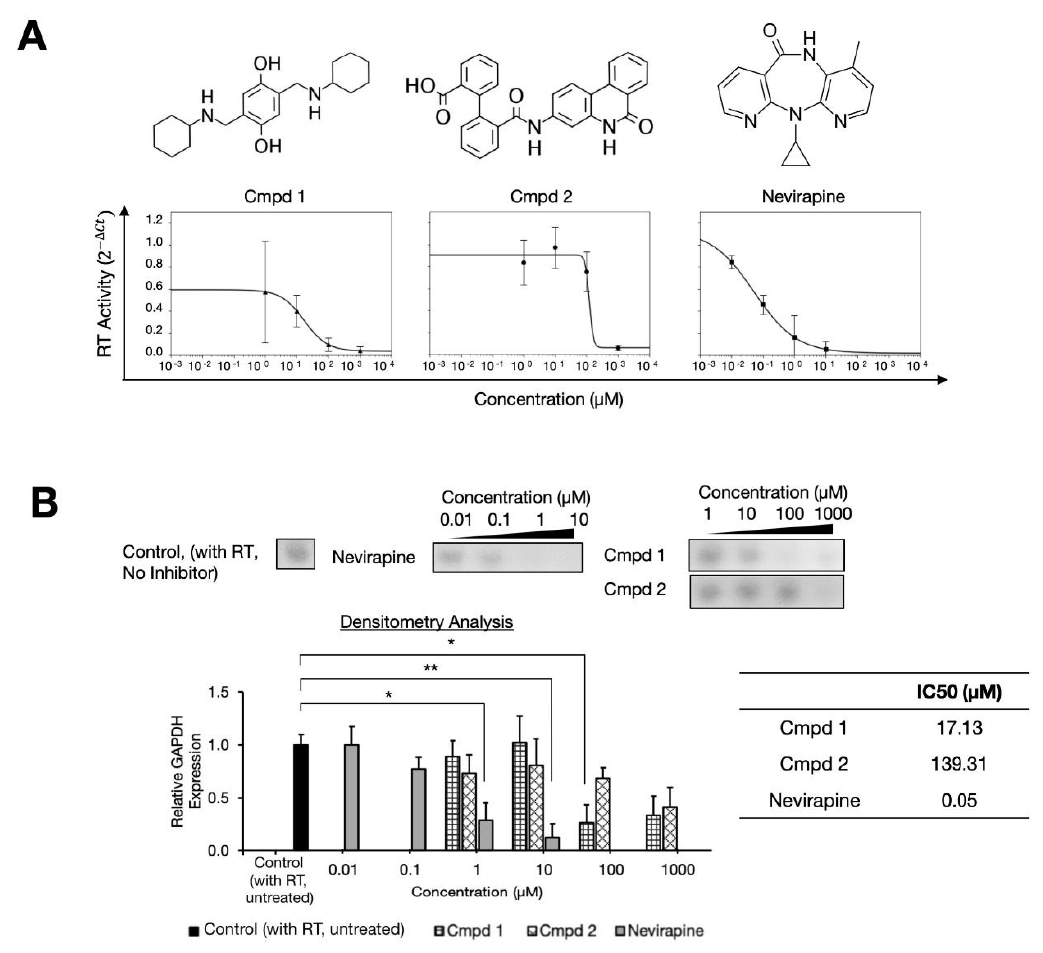
Figure 1. The two compounds that inhibited HIV-1 reverse transcriptase (RT) function. ( A ) RT inhibition was demonstrated via the best-fit curves (using ∆ Ct) of compound 1 (NSC48443), compound 2 (NSC127133), and nevirapine (as a positive control). Chemical structures of the compounds are shown on the top. ( B ) Densitometry analysis is shown with various concentrations of compounds 1 and 2 (1 µ M to 1000 µ M), nevirapine (0.01 µ M to 10 µ M), and the control. Asterisks depict p -values of statistical tests of the mean di ff erence against the untreated control (with RT and no inhibitors added), p < 0.05 (*) and p < 0.01 (**). All of the experiments were performed in triplicates. The densitometric values were estimated and normalized against those of the control, using Fiji software